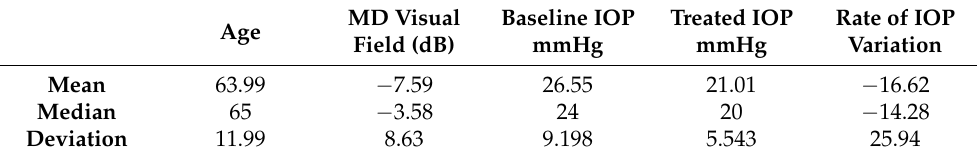
Table 2. IOP and Visual field data.